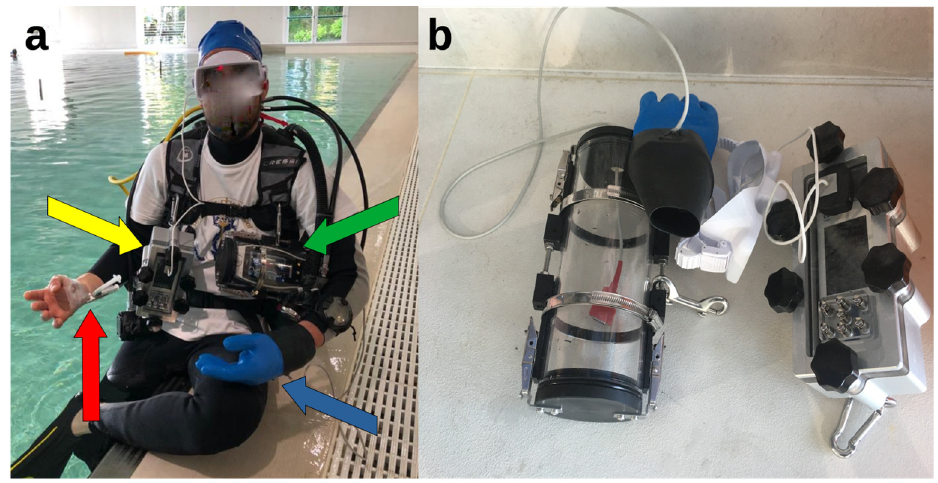
Figure 1. The experimental set-up at the poolside. ( a ) The volunteer SCUBA diver equipped with marinized pulse oximeter (yellow arrow) and ORi™ (green arrow) devices; the arterial access on the non-dominant hand (red arrow); the SCUBA diving glove (blue arrow). ( b ) Insulating devices for the pulse oximeter (on the right) and for the ORi™ device (on the left, with its sensor inside the SCUBA diving glove).